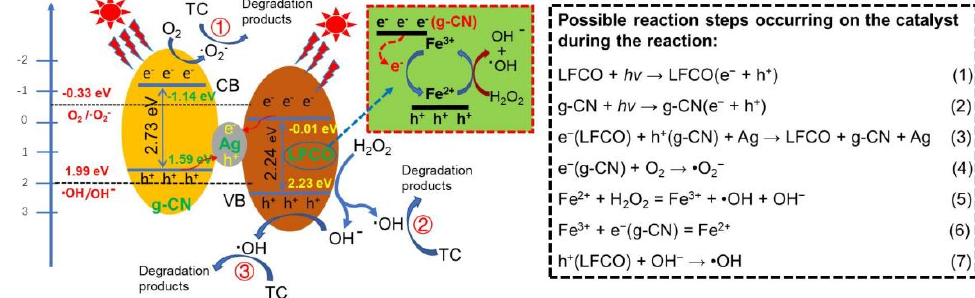
Figure 18. Mechanism of photo—Fenton degradation of tetracycline hydrochloride over the ternary LFCO/Ag/g-CN heterojunctions under visible-light irradiation. Used with permission from [182]. Copyright 2022 John Wiley and Sons.